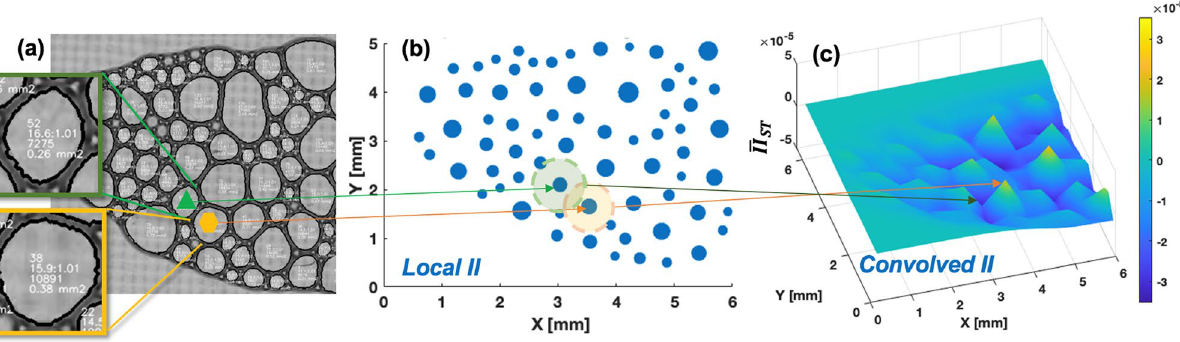
Figure 5. Inter-bubble information extracted by the convolved information index (II): ( a ) Enlarged snapshot at time step 2 of the left part of the elongated bubble array. Yellow hexagon marks the circular shape (i.e., convex 6 ) whereas green triangle bubble C > 1 ; see a nearly circular shape in inlet) with nearly over six sides ( n ≥ marks the concave bubble ( C < 1 ; see a nearly rectangular shape in inlet) with less than six sides ( n < 6 ) . White numbers in inlet stand for each bubble’s processed values that mean the bubble index, (pixel perimeter) 2 / (pixel area):(pixel area of the fitted eclipse)/(pixel area), pixel area, and real scaled area, respectively; ( b ) Local II of each bubble by perimeter-proportional scatter plot. Yellow and green shaded regions illustrate the spatial 0.437 mm) centered at the hexagon- and triangle-marked bubbles, respectively; ( c ) GPRL- convolution ( L = generated convolved spatio-temporal II distribution with the local maximum near the yellow hexagon and local minimum near the green